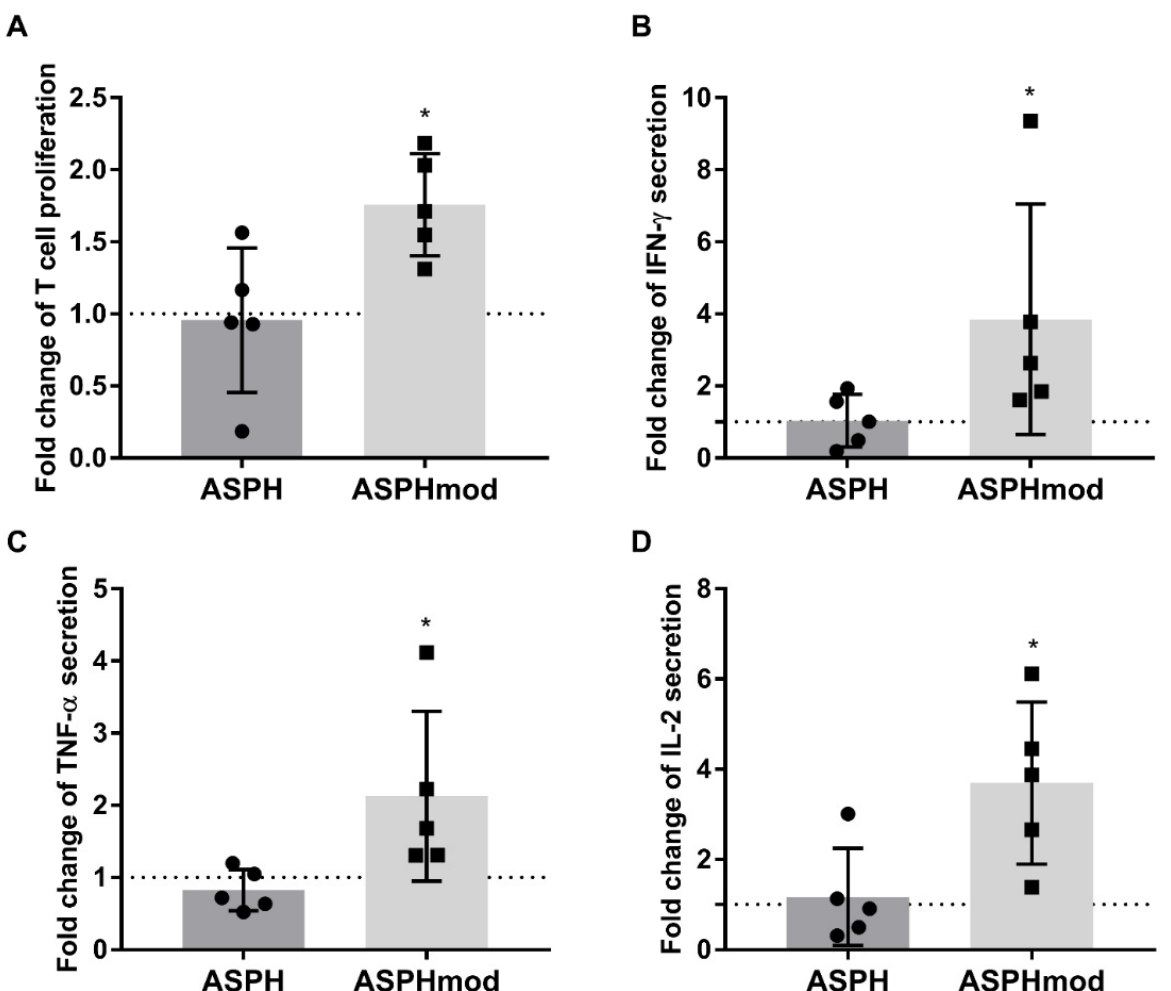
Figure 6. ASPHmod-pulsed moDCs stimulate increased T cell proliferation and cytokine produc- tion. Fold changes in ( A ) T cell proliferation, or the production of ( B ) IFN γ , ( C ) TNF α and ( D ) IL-2 after restimulation with ASPH- or ASPHmod-pulsed moDCs relative to cells restimulated with the non-pulsed moDC control. Data represent the means ± SD of five individuals: * significantly greater, p < 0.05 (( A , C , D ): unpaired Student’s t test; ( B ): Mann–Whitney test).